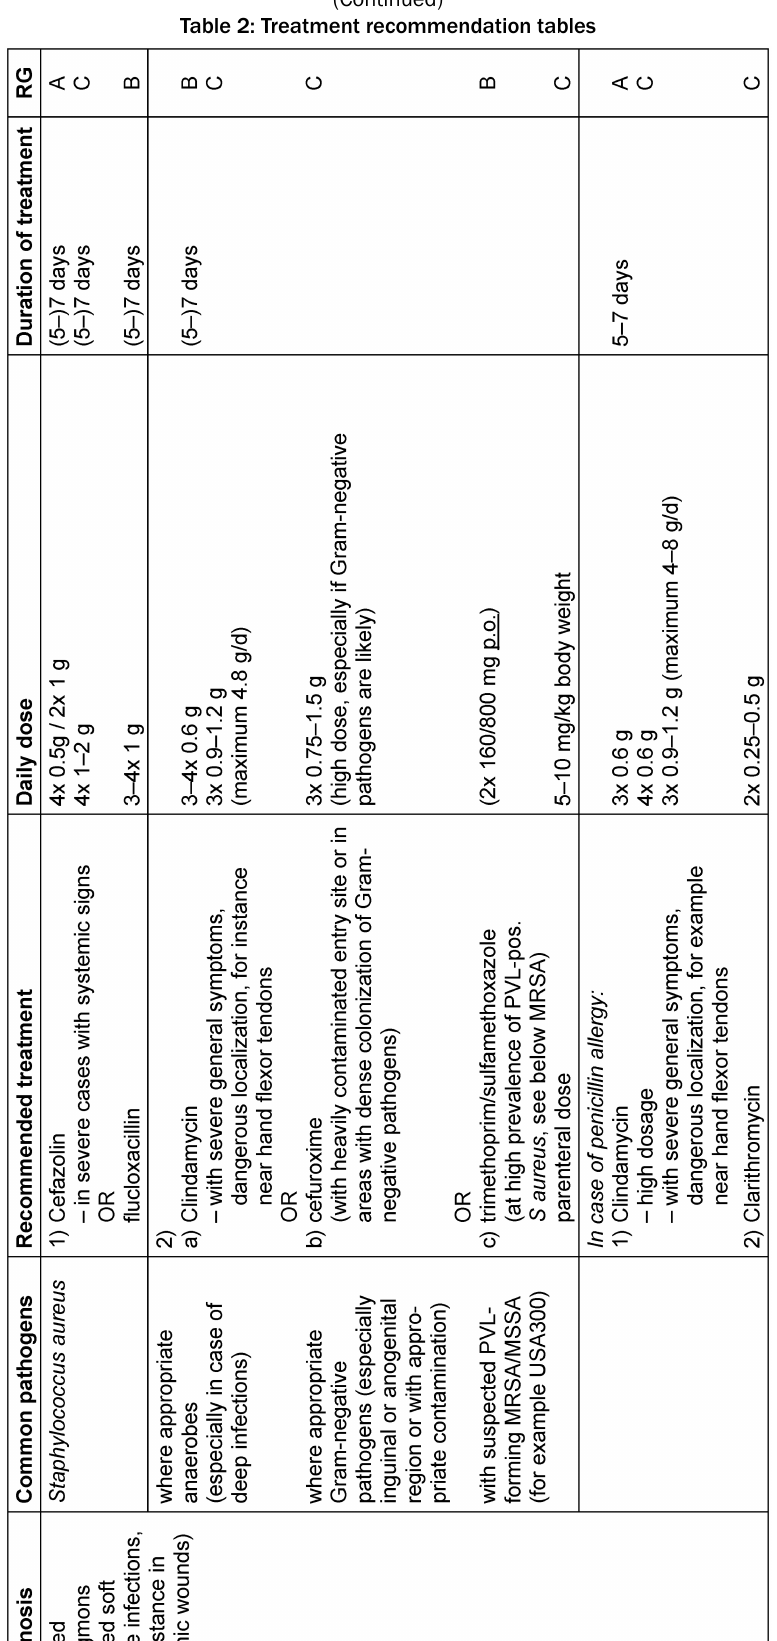
Table 2: Treatment recommendation